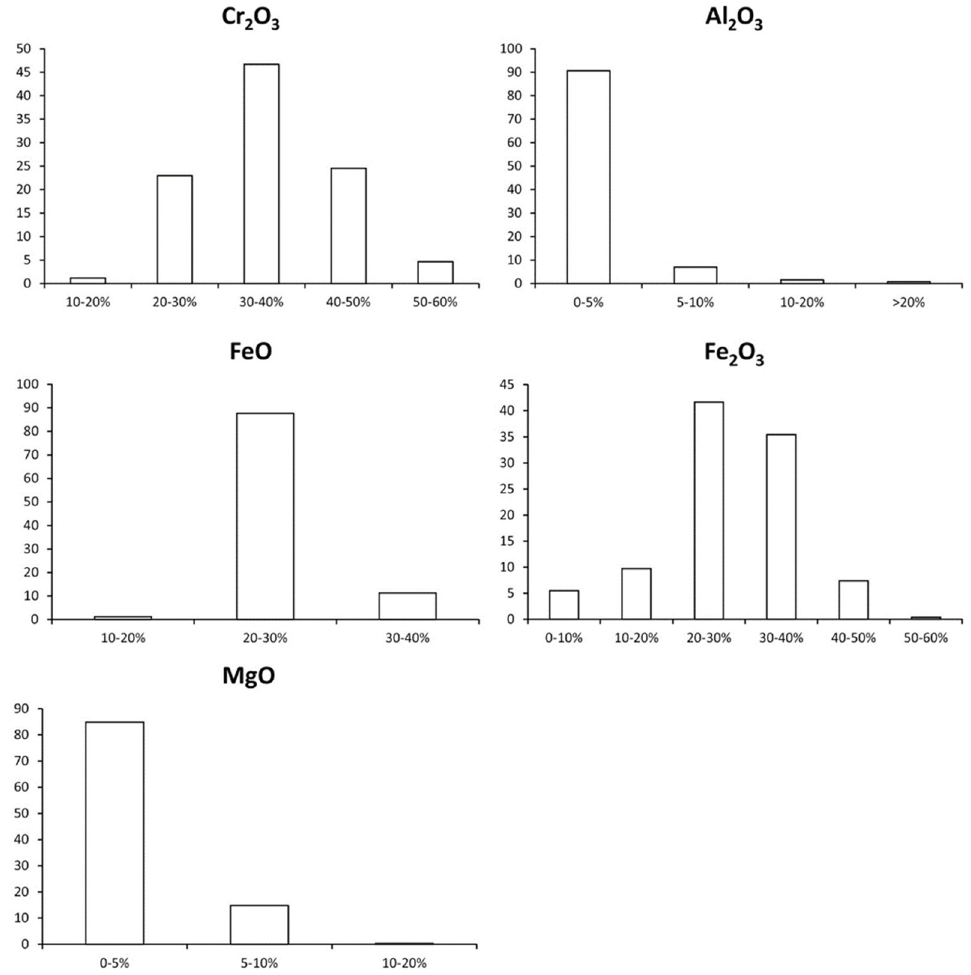
Figure 2. Frequency distribution of Cr 2 O 3 , Al 2 O 3 , FeO, Fe 2 O 3 , and MgO in the studied spinels.